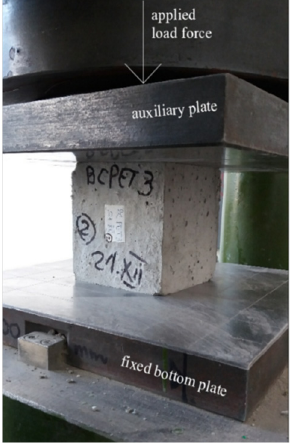
Figure 5. Experimental test of the compressive strength.